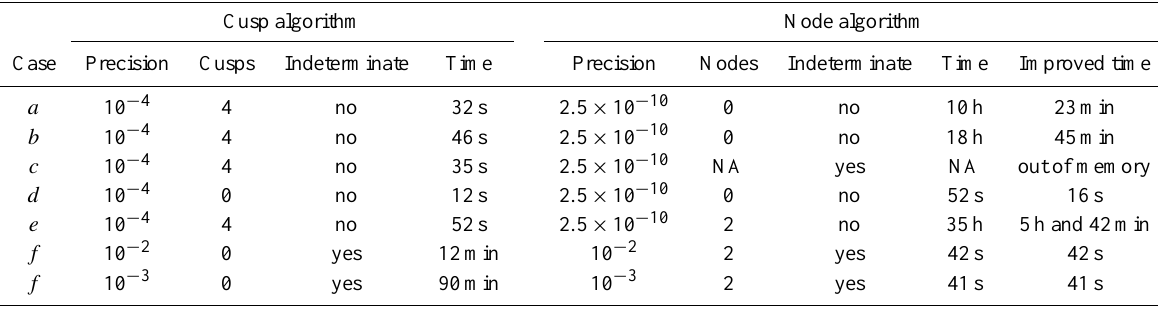
Table 2. Algorithms performances on the robotic manipulators of Table 1. Cusp